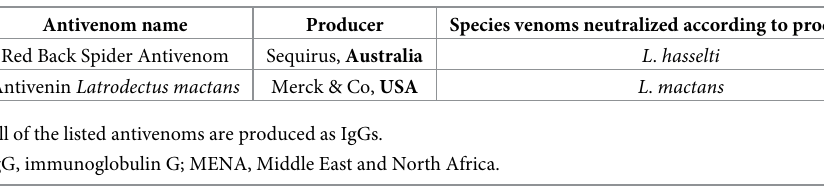
Table 3. Spider antivenoms currently available for use in MENA.